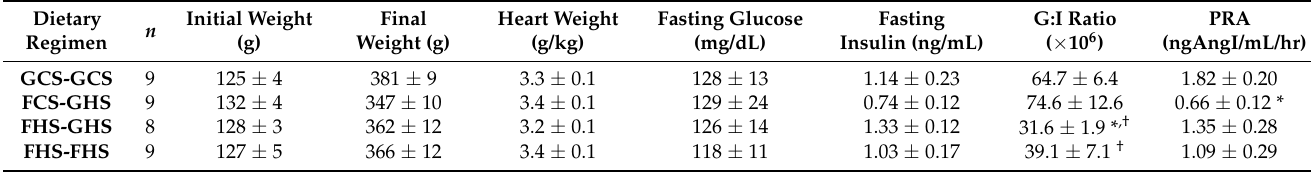
Table 1. Initial and Final Body Weights, Heart Weights, Glycemic Parameters and Plasma Renin Activity among the Four Groups of Rats.